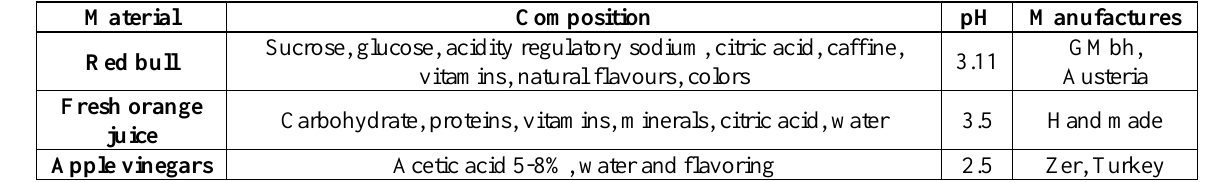
Table 2: Acidic drinks used in this